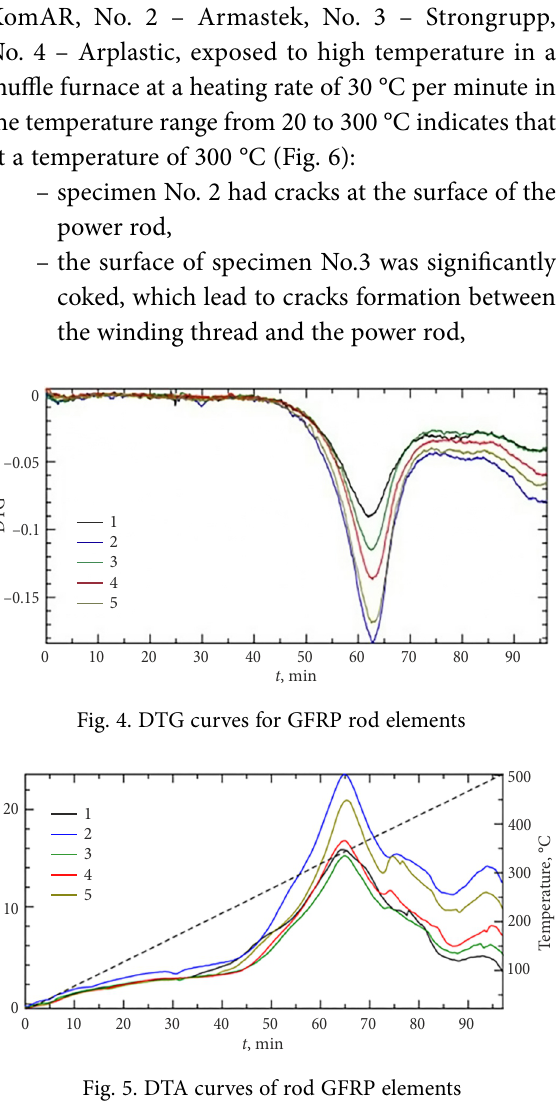
Fig. 5. DТА curves of rod GFRP elements